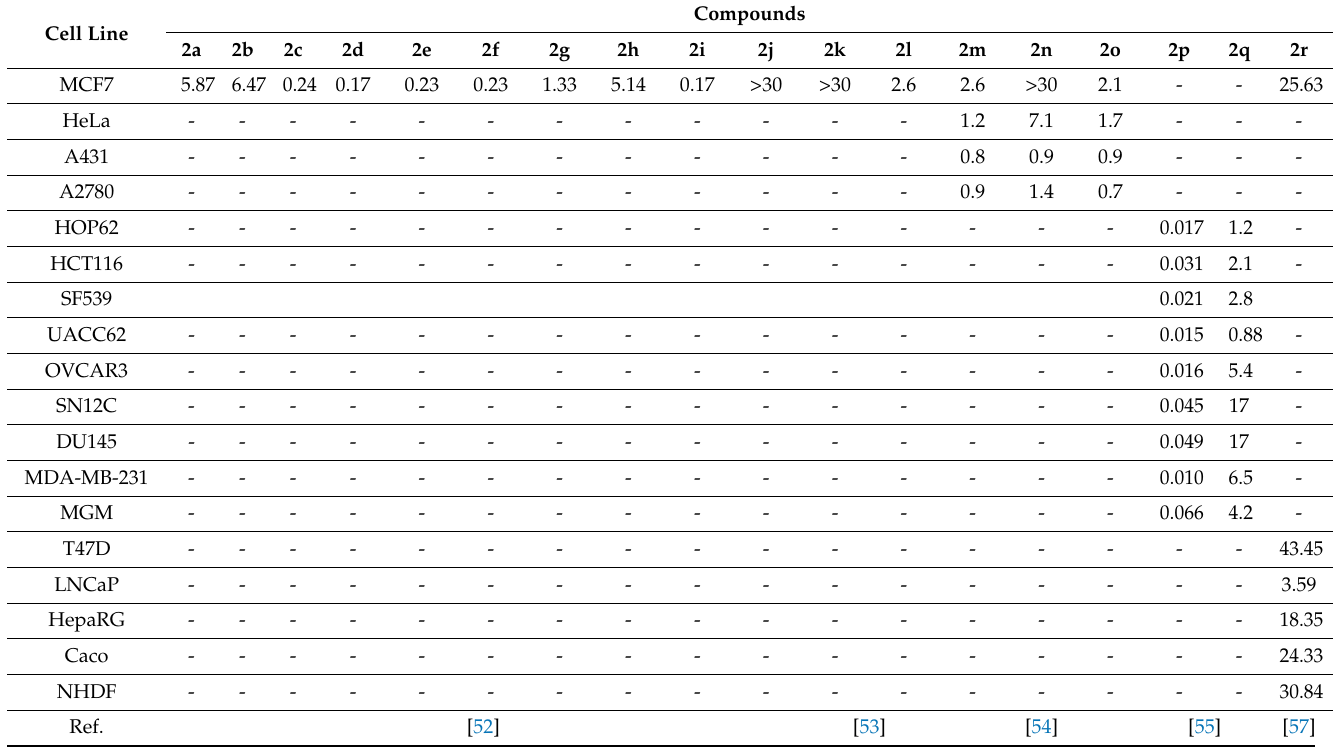
Table 2. IC 50 values ( µ M) of the synthesized estrane oxime derivatives.